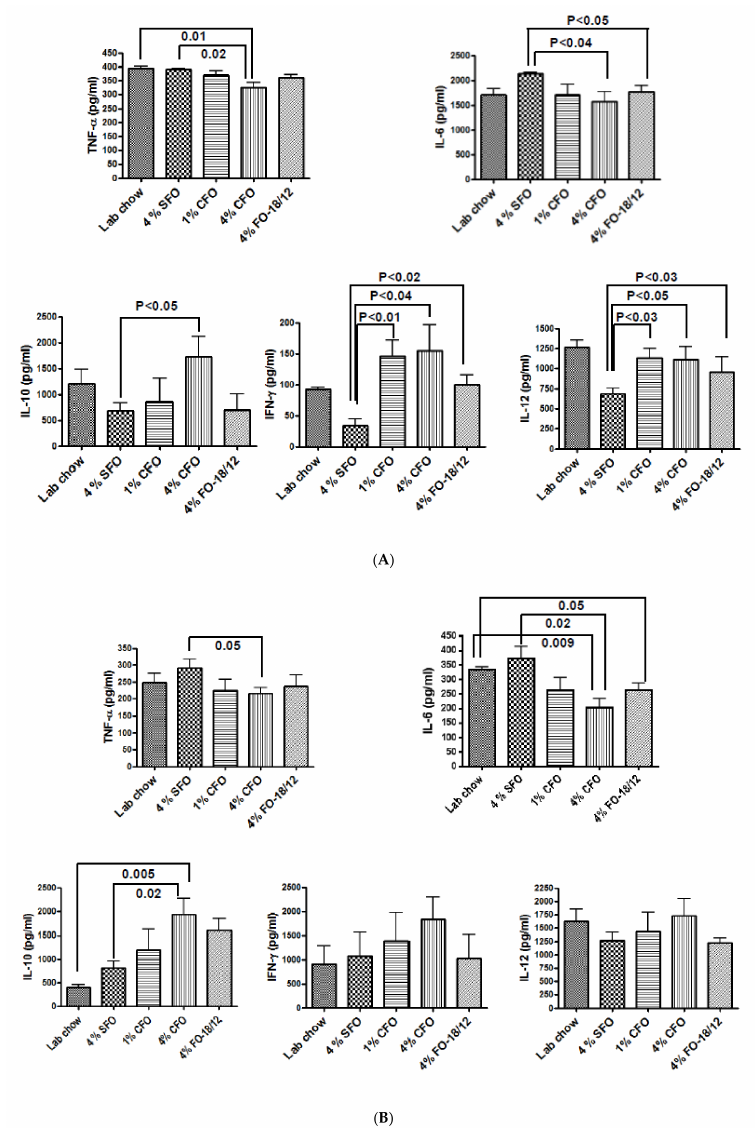
Figure 4. CFO modulates LPS stimulated cytokines production. Twelve-months-old C57BL / 6 mice were fed experimental diets for 12 months. Twenty-four-months-old mice were then sacrificed, and bone marrow cells ( A ) and splenocytes ( B ) were isolated and cultured and then stimulated with 5 µ g / mL LPS. After 24 hrs, culture media were collected and analyzed for TNF-a, IL-6, IL-10, IL-12 and IFN-g by standard ELISA techniques. Each value represents the mean ± S.E.M. of two independent triplicate cultures. P -value < 0.05 was considered significant by Student’s t-test. SFO, sa ffl ower oil containing 70%–80% ω -6 linoleic acid; CFO, concentrated fish oil containing 46.5% EPA and 37.5% DHA; FO-18 / 12, regular fish oil containing 18% EPA and 12%